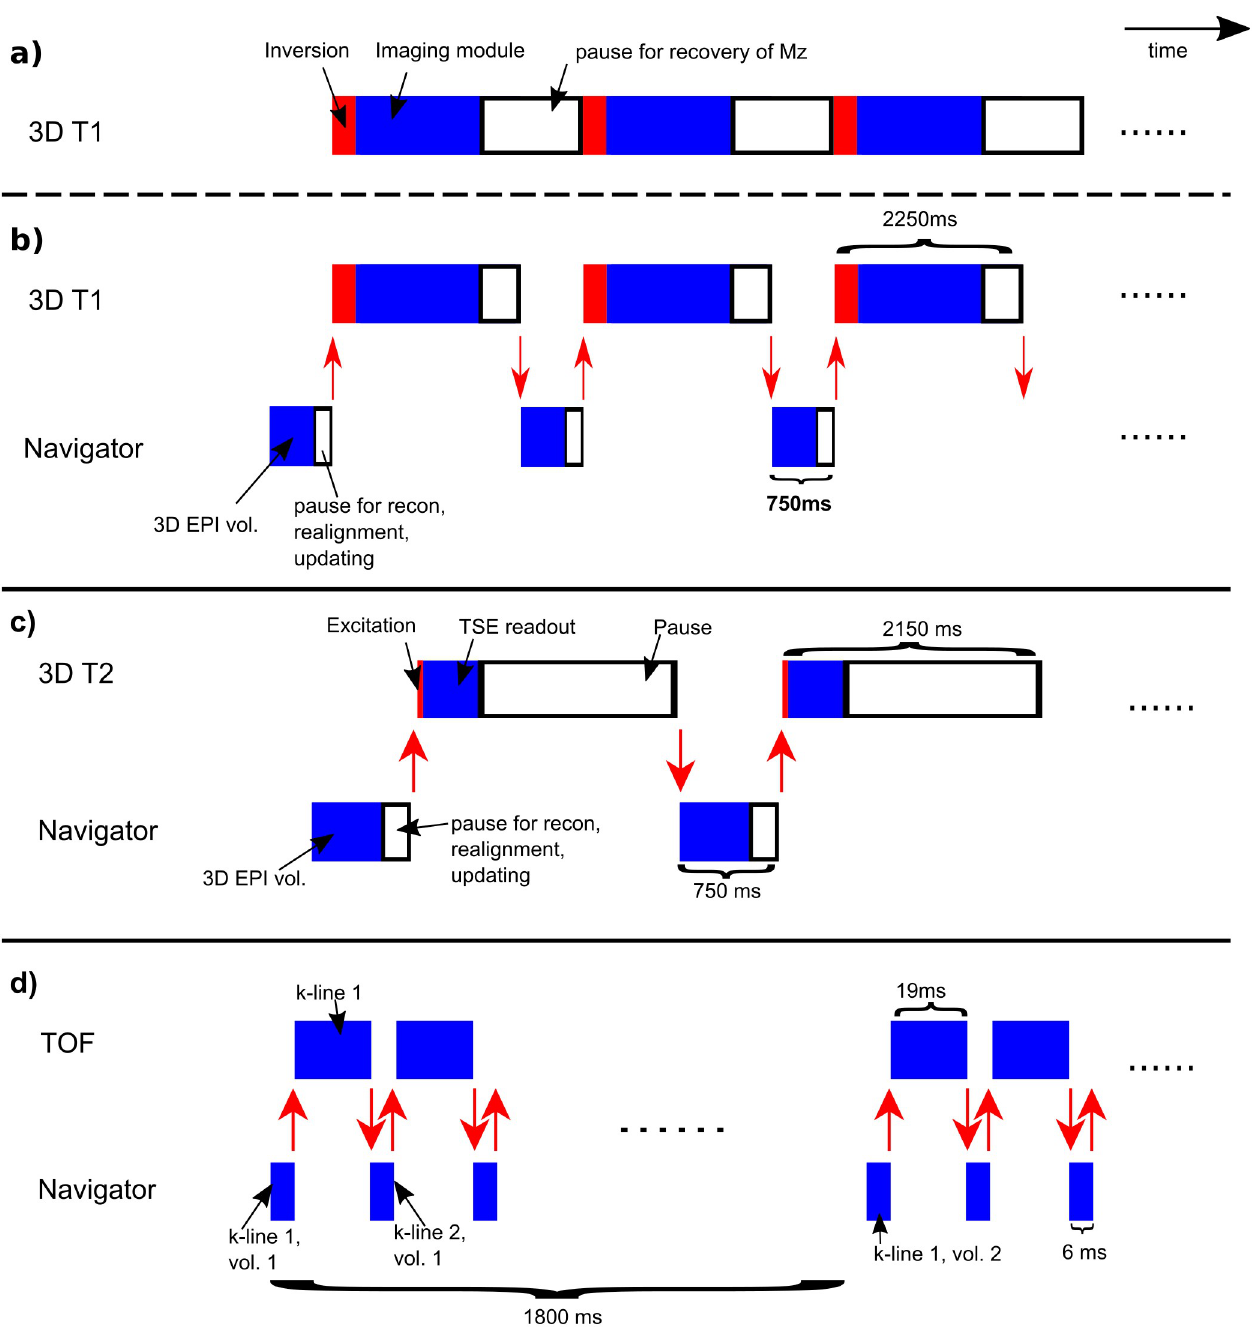
Fig 1. Overview of the switching between host sequences and navigators with associated timings. a . The 3D T1-weighted sequence without an interleaved navigator. b – d . Sequence layouts after incorporation of navigators. In all cases, the host sequence and navigator were defined as two different sequences in the standard user interface. The red arrows represent the switch between